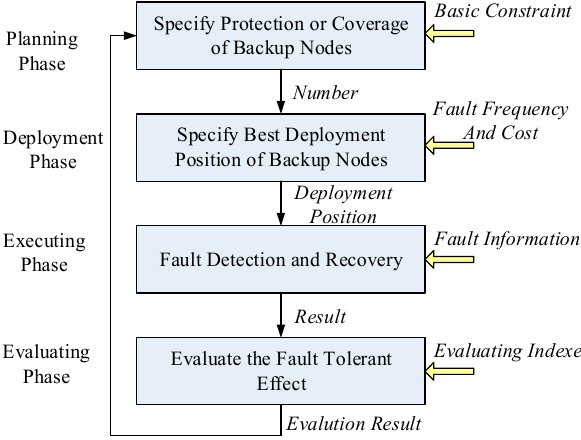
Figure 3. The design proposal of a fault tolerant On-Road Sensor Network.